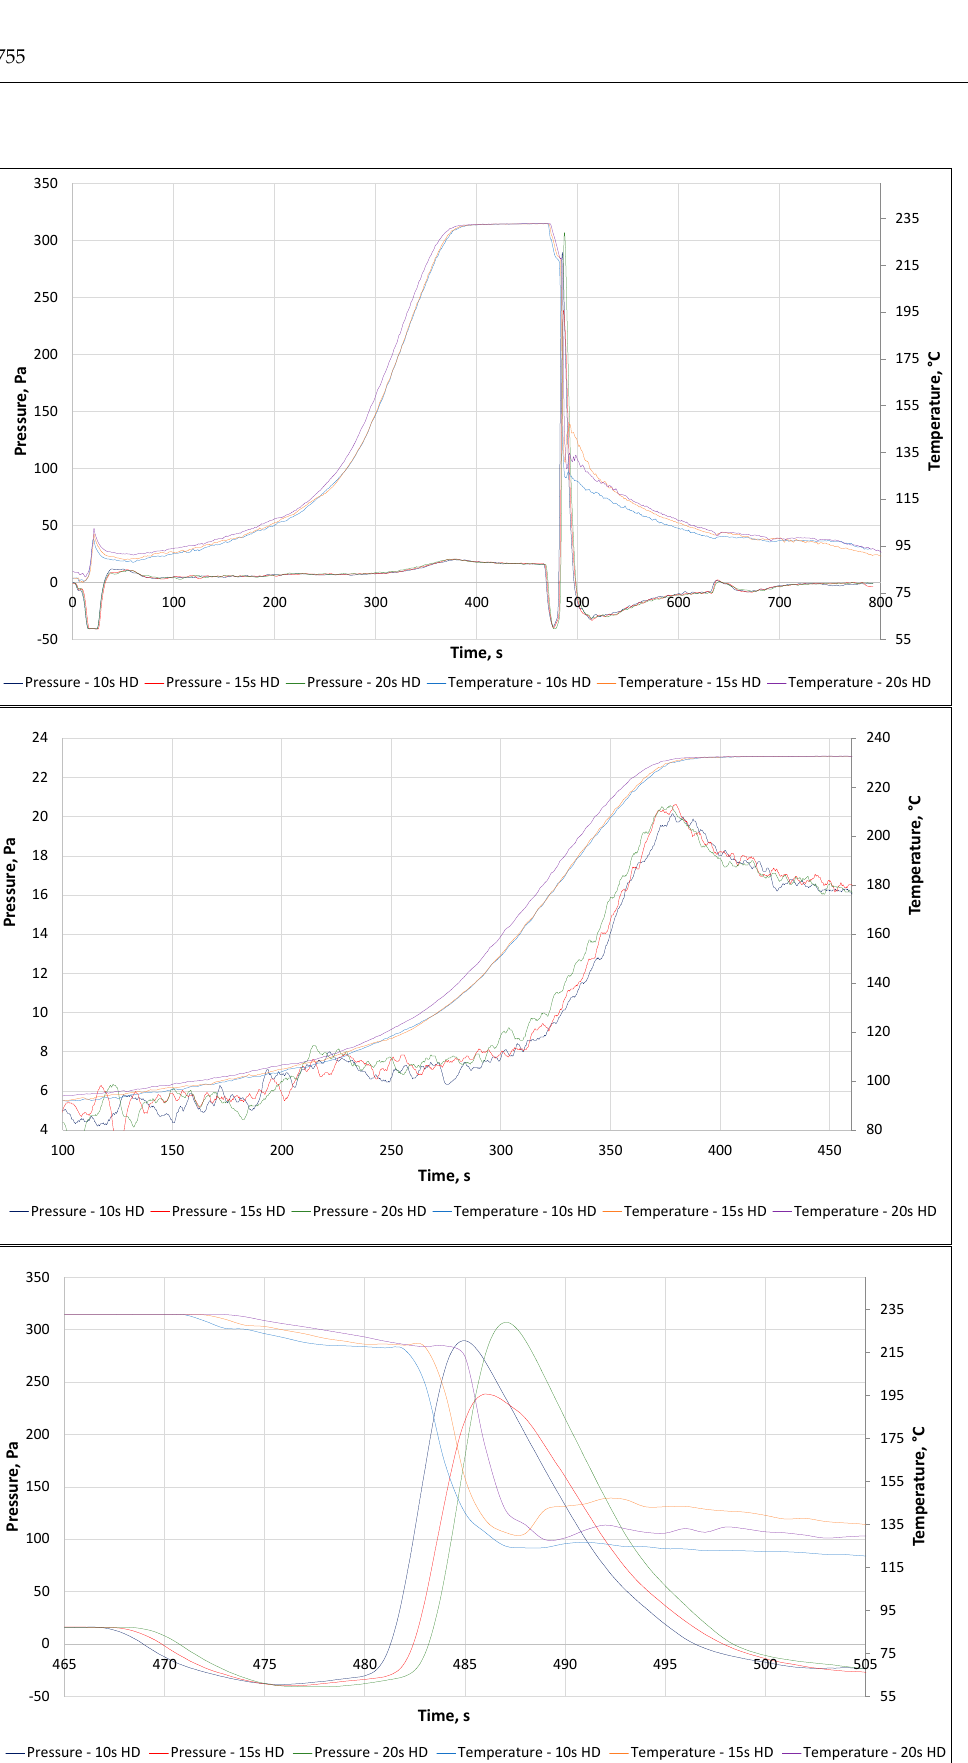
Figure 8. Pressure and temperature measurement with the variation of the heating delay; top: full profile; center: heating phase; bottom: solder break phase (HD = heating delay).